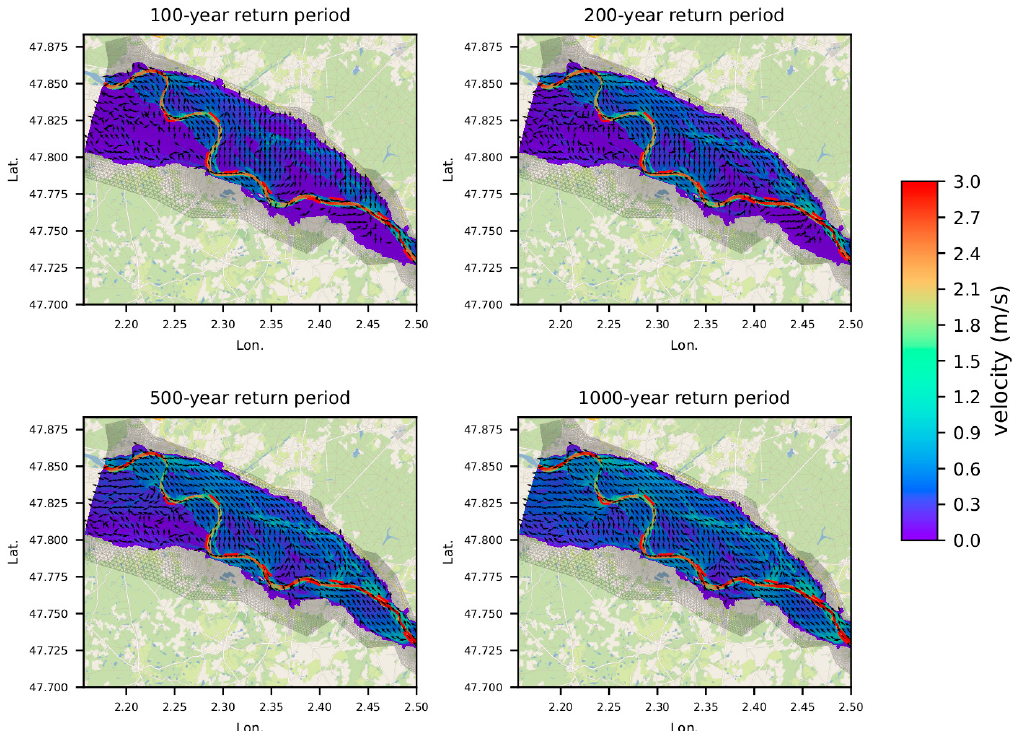
Figure 5. Probabilistic inundation map of 90th percentile flow scalar velocity with velocity vectors for 100, 200, 500 and 1000-year return period floods with location of potential dike breaches ( ― ).